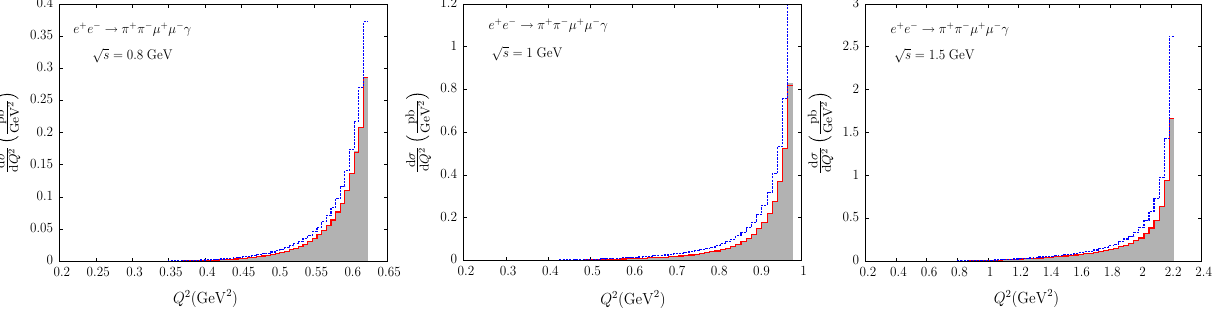
Fig. 14 The differential cross sections of (10) as functions of invariant mass of the π + π − μ + μ − -system. Legend as in Fig. 11